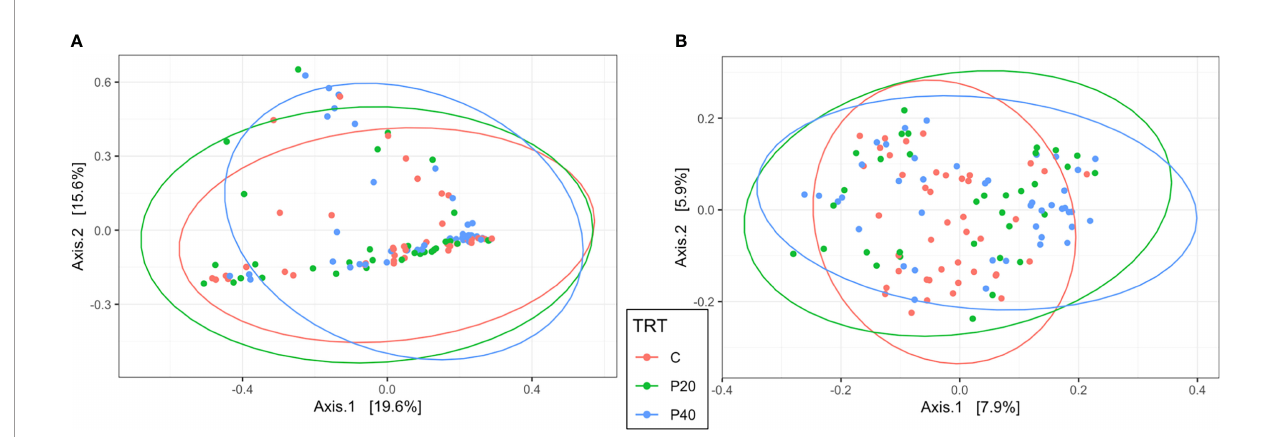
FIGURE 3 | Beta diversity by principal coordinate analysis with Bray Curtis distances for protein supplementation treatment in the uterus ( A ; R 2 = 0.02, P = 0.06) and rumen ( B ; R 2 = 0.02, P = 0.008). Signi fi cance was determined by PERMANOVA with 999 permutations. Ellipses represent 95% con fi dence interval. CON, control, 10% crude protein supplement; P20, 20% crude protein supplement; P40, 40% crude protein supplement.